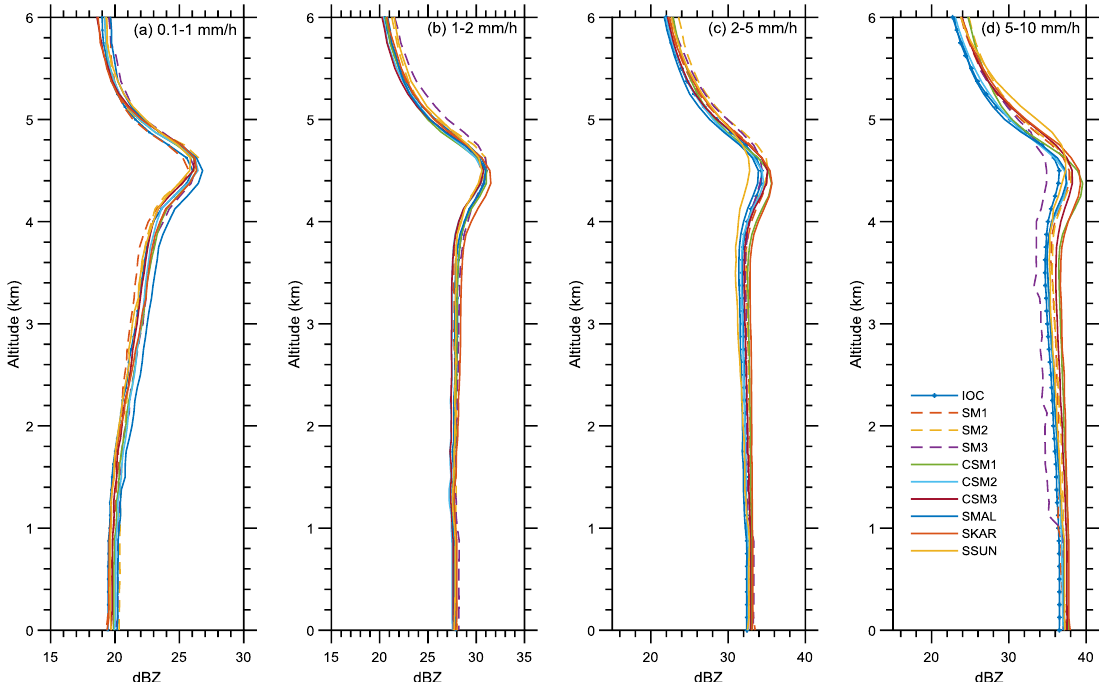
Figure 4. Vertical profile of reflectivity factor ( Z ) for ten selected locations of stratiform rain for a) very light rain, b) light rain, c) moderate rain, and d) heavy rain.